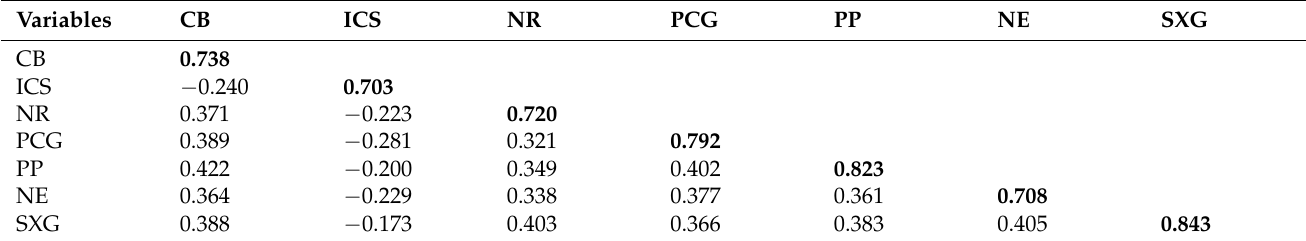
Table 2. Discriminant validity for first stage measurement model.